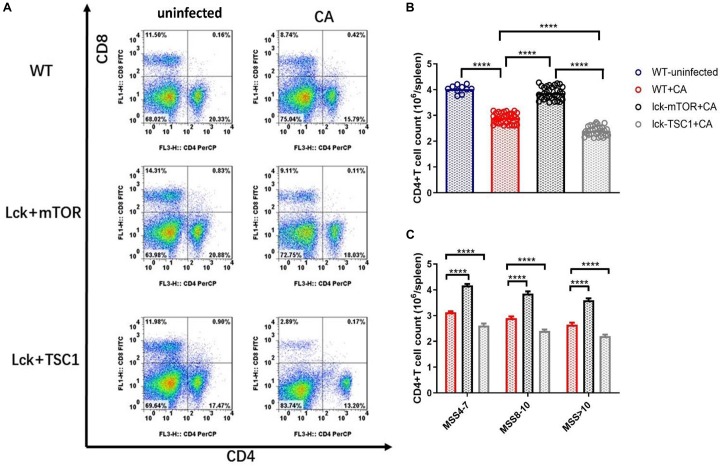
CD4+ T cell count during Candida sepsis is affected by mTOR pathway. Splenocytes of specific gene knockout mice were obtained at 12 h after Candida injection. (A–C) Gating strategy for CD4+CD8– and CD4–CD8+ T cells by flow cytometry analysis. Mean ± SD, 10 mice per MSS group (“+CA” groups contained all infected mice of three MSS groups), analyzed by one-way analysis of variance multiple comparisons. ****P < 0.0001.